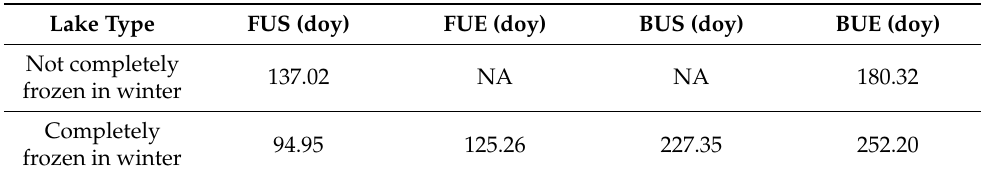
Table 2. Lake ice phenology characteristics in Central